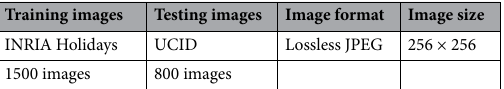
Table 1. Description of datasets used in the